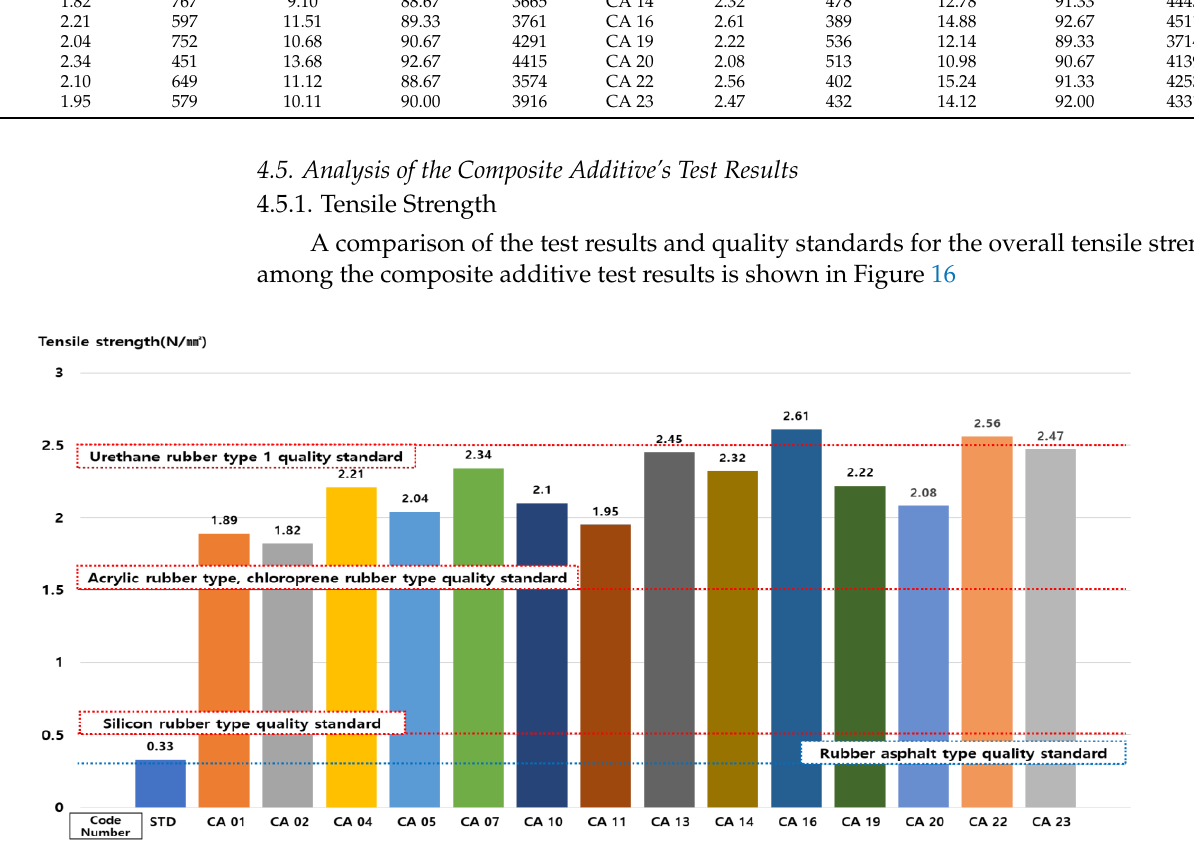
Table 13. Single mixture ratio additive properties.